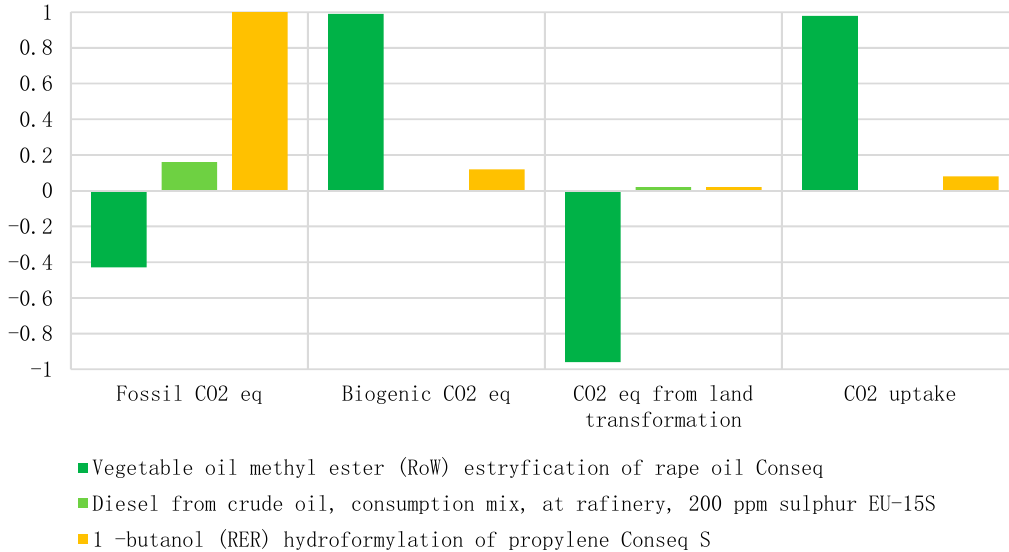
Figure 11. Particular carbon dioxide emissions occurring in production processes of selected fuels (%).